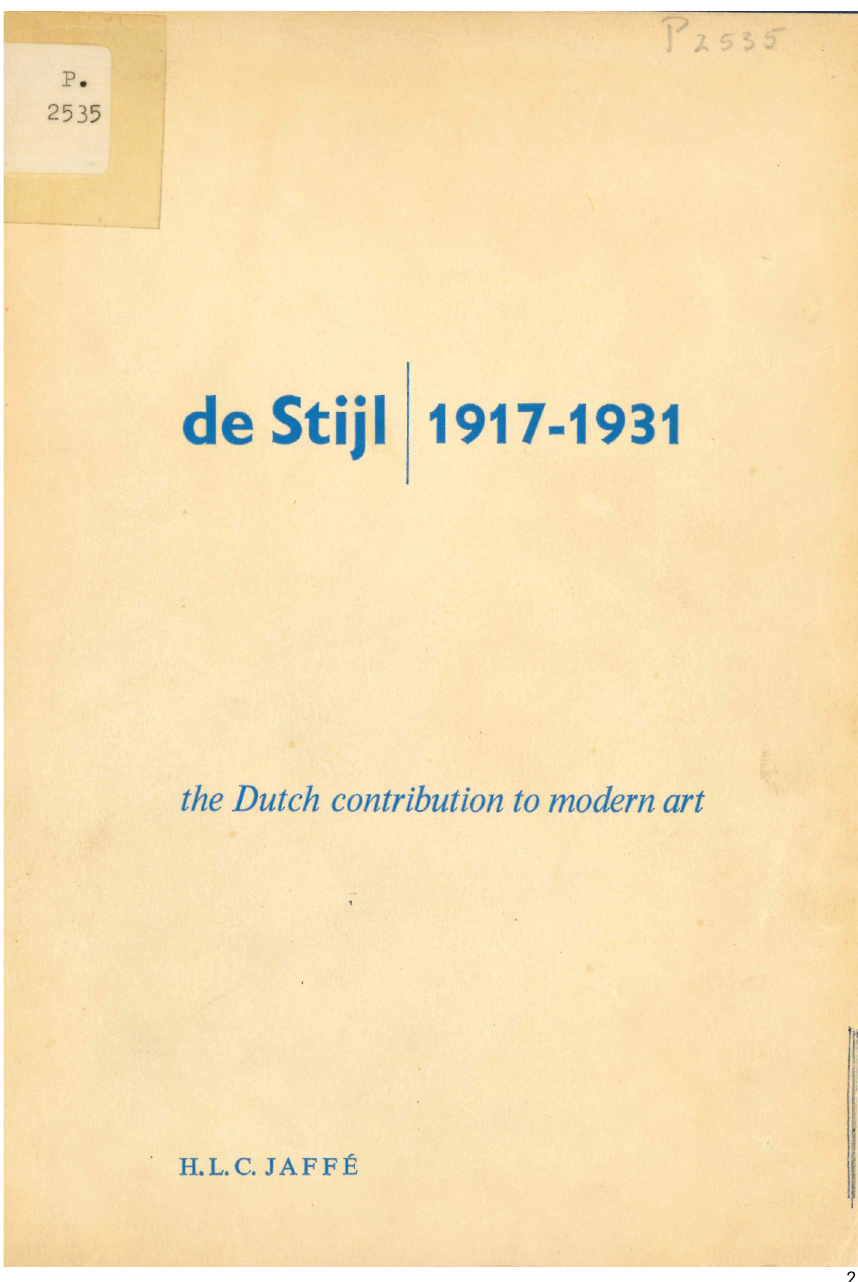
Fig. 2 Front cover of the book De Stijl, the Dutch contribution to Modern Art by Hans Jaffé, 1956. Photo by Patricia